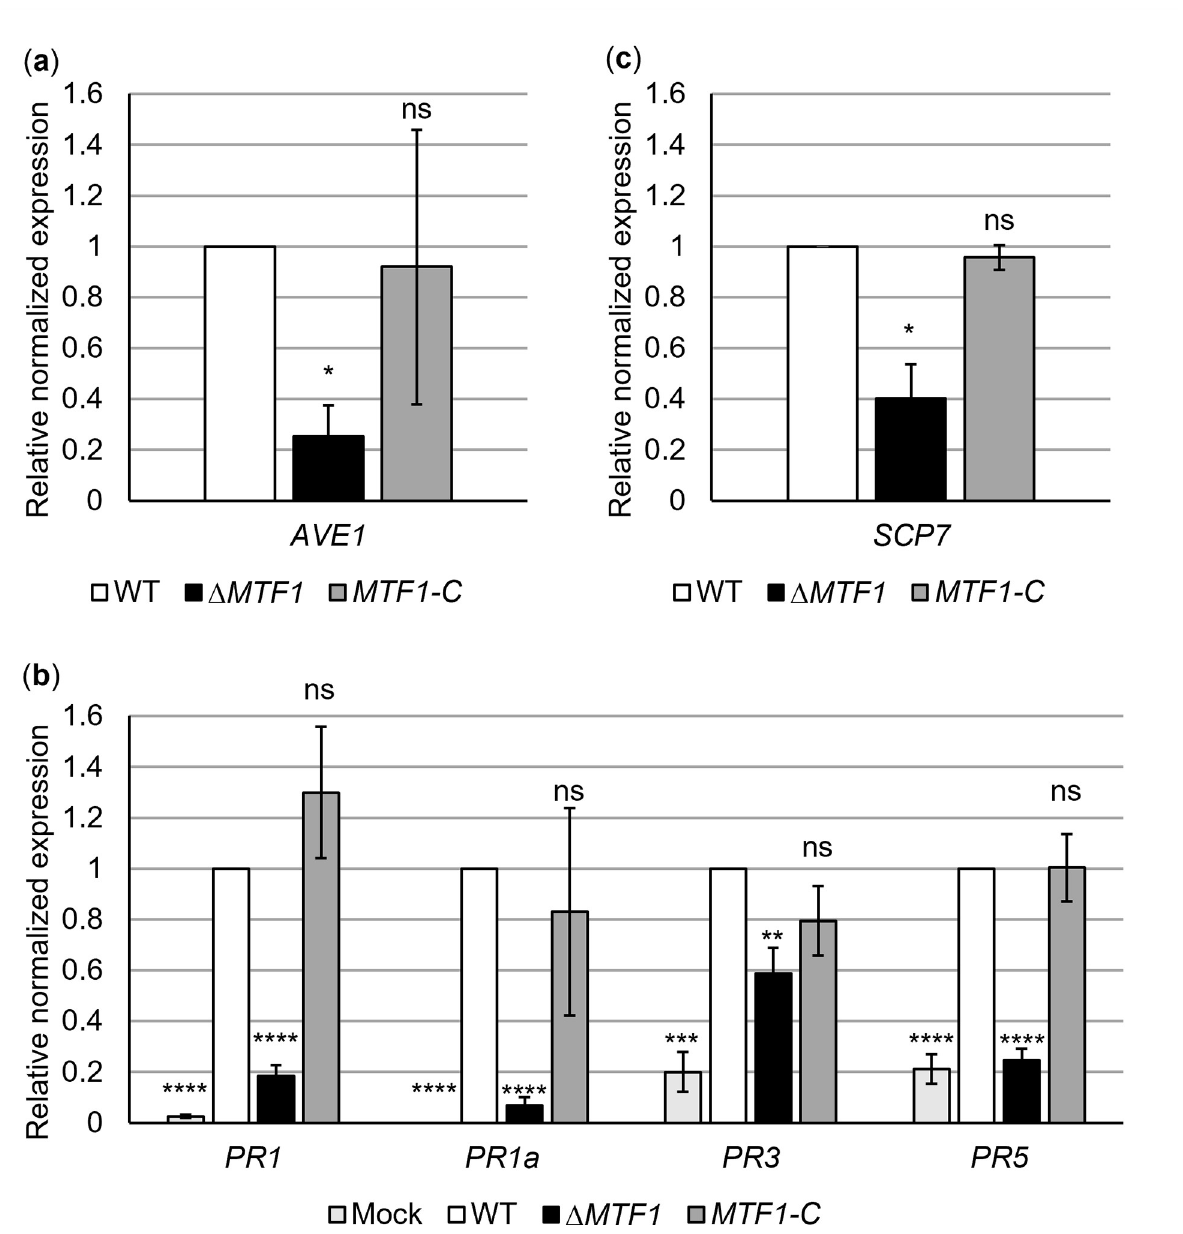
Fig 9. Expression of fungal effector genes and pathogenesis-related protein (PR) genes in tomato plants is increased in the presence of Verticillium dahliae MTF1 . Transcript levels were analyzed by reverse transcription-quantitative PCR and gene expression levels in wild-type were set to one. Significant differences from wild-type (WT) were determined using t -tests. Means of three independent experiments are shown with error bars representing the SE of the means. (a,c) Strains were cultured in extracted tomato xylem sap for 8 h following preculture in simulated xylem medium. Means of three biological replicates normalized to the transcript levels of reference genes H2A and EIF2B are shown. (a) In the absence of MTF1 ( Δ MTF1 ), expression of the virulence factor Ave1-encoding gene was reduced by almost 80% compared with wild-type and the MTF1 complementation strain ( MTF1 -C) ( � , P < 0.05; ns, not significant). (b) Expression levels of tomato PR genes were quantified in hypocotyls 21 days after inoculation with V . dahliae JR2 wild-type, Δ MTF1 or MTF1- C spores. Water-treated plants (mock) served as controls. Hypocotyls from 13 to 15 plants per treatment were pooled ( n = 1). Means of six biological replicates normalized to the transcript levels of reference genes EF1 α and α TUB are shown. The expression levels of PR1 , PR1a , PR3 and PR5 did not differ significantly between wild-type and MTF1- C-infected plants. In plants treated with water or Δ MTF1 , the expression levels of PR genes were significantly lower ( �� , P < 0.01; ��� , P < 0.001; ���� , P < 0.0001). (c) The transcript level of the Scp7 effector-encoding gene was significantly reduced in Δ MTF1 to 40% of the wild-type level.